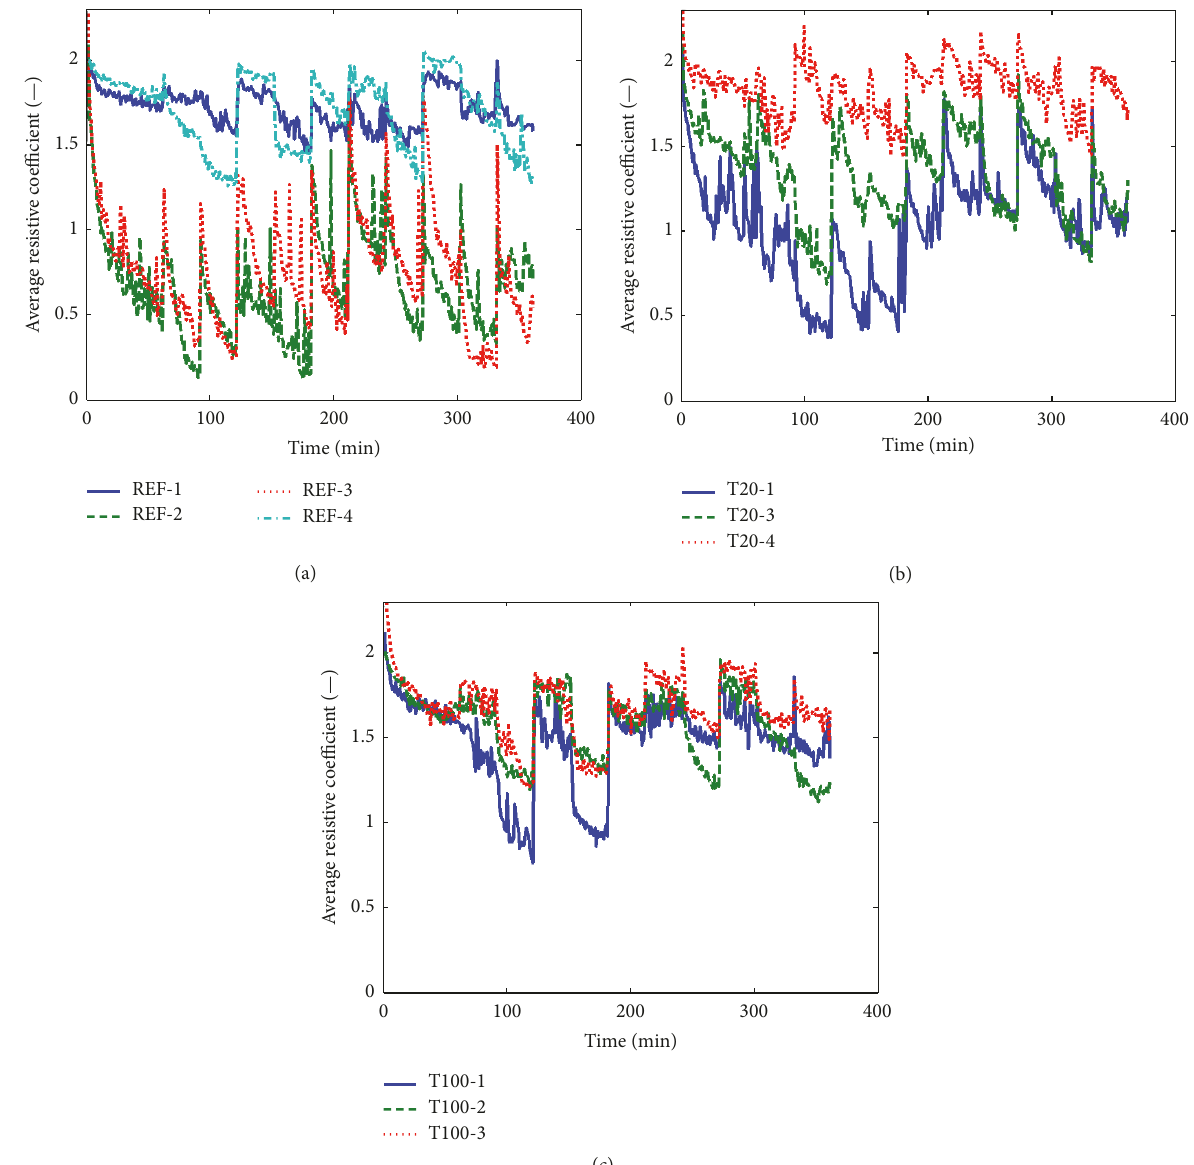
Figure 9: Measured resistive coefficient for each experiment. (a) REF. (b) T20. (c) T100.